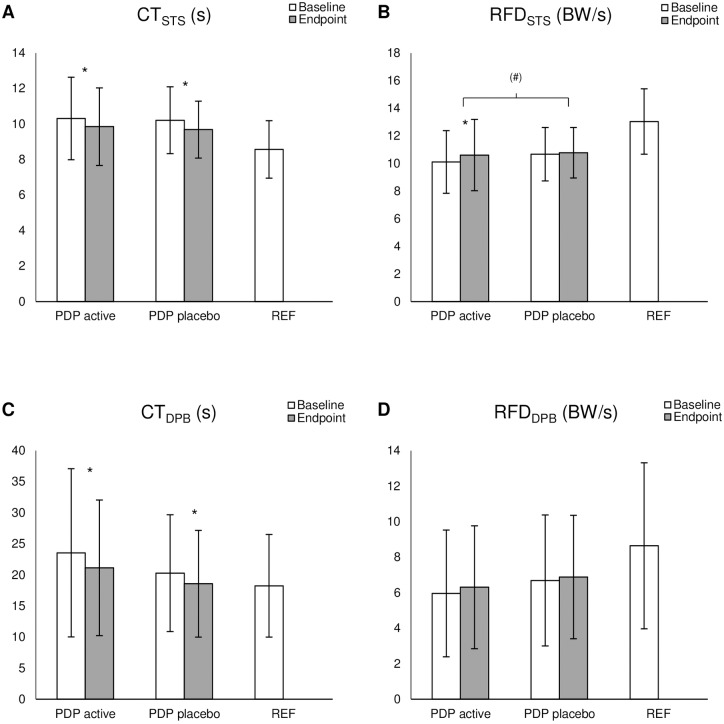
Results for all persons with Parkinson’s disease.A Completion time of the sit-to-stand task (CTSTS), B rate of force development of the sit-to-stand task (RFDSTS), C completion time of the dynamic postural balance task (CTDPB), and D rate of force development of the dynamic postural balance task (RFDDPB) for all participants with Parkinson’s disease receiving active (PDP active) or placebo (PDP placebo) transcranial pulsed electromagnetic fields and for healthy reference participants (REF). Bodyweight (BW). Data presented as the mean ± SD. * P≤0.05 for main effect of time. (#) 0.05 < P < 0.1 for the group×time interaction effect.